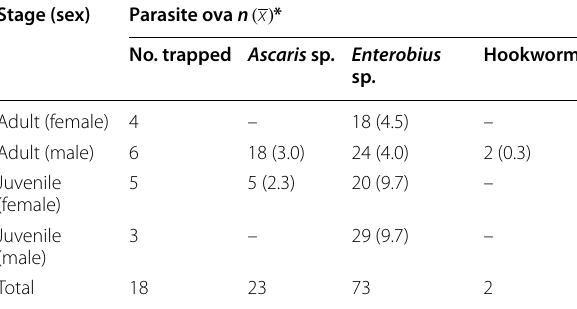
Table 1 Parasite ova detected in Agama lizards trapped on the